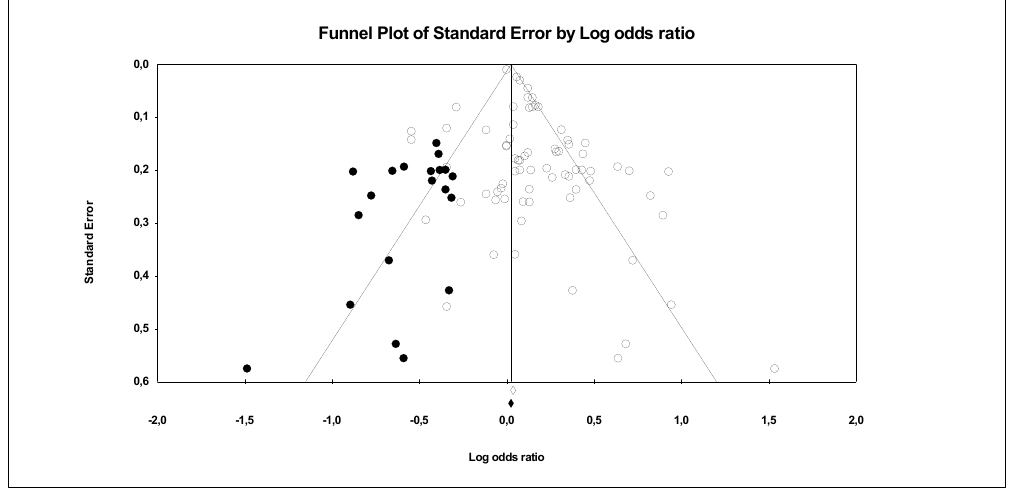
Figure 8. Funnel plots of observational studies on the association of PFCs exposure with their risk factors. The publication bias is adjusted by imputing the missing studies based on the asymmetry of the funnel plot. (●) Plot Imputed and ( ○ ) Plot observed studies. Egger’s linear regression test (Intercept 1.4, t = 1, p = 0.18). Adjusted values ‘Trim and Fill’ test (1.01, CI = 0.94, 1.08).